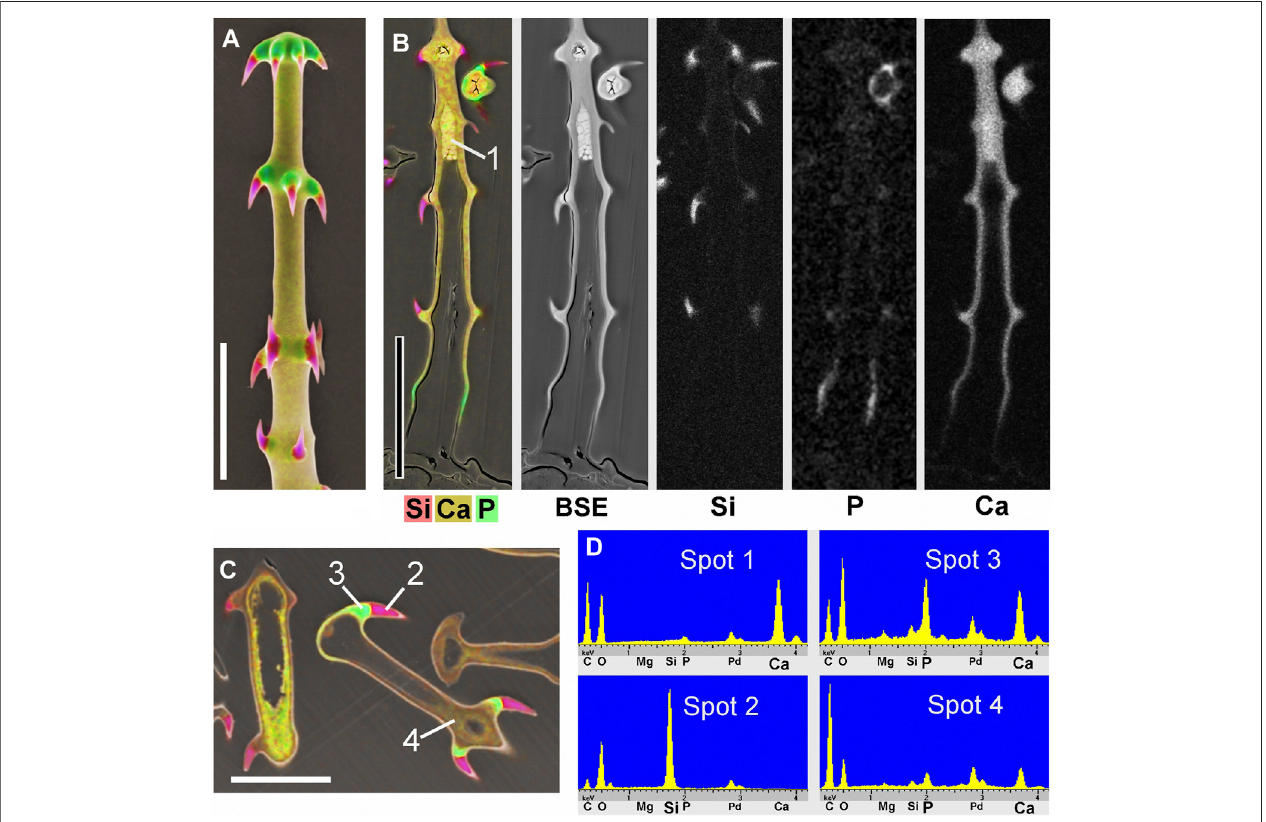
FIGURE 3 | Caiophora clavata glochidiate trichomes with three biominerals; element-mapping SEM images and EDX spectra of selected spots. Colours characterize different elements: red (cid:1) Si; yellow to brown (cid:1) Ca; green (cid:1) Ca + P. (A) surface view; (B – C) longitudinal sections through embedded trichomes treated with different preparation methods: (B) Freeze substitution; grayscale mapping images of elements show lower concentrations. (C) conventional formaldehyde fi xation. (D) EDX spectra from four locations indicated in (B) and (C) indicate different biominerals: calcium carbonate (Spot 1); silica (Spot 2); calcium phosphate (Spot 3); but only low Ca concentration in cell lumen after formaldehyde fi xation (Spot 4). The freeze substitution-prepared sample (B) shows well-preserved Ca-minerals in cell wall and lumen, silica in barbs, and P in basal cell wall. Conventional preparation (C) caused irregular deposits in cell lumen and loss of Ca in walls, but silica and